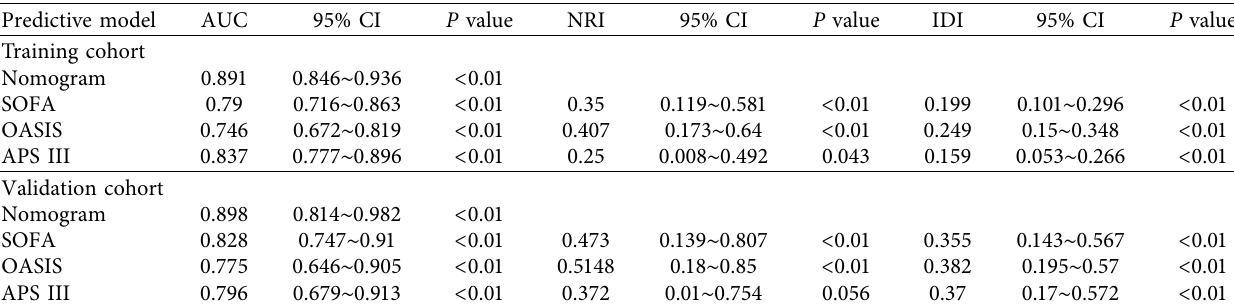
Figure 3: ROC curves for the nomogram, SOFA, OASIS, and APS III in the training cohort (a) and validation cohort (b). Te nomogram includes RA, age, temperature, bun, AST/ALT, hemoglobin, bilirubin, potassium, and heart rate. In both groups, the nomogram had higher AUC values than SOFA, OASIS, and APS Table 3: Predictive performances and validation of the nomogram.